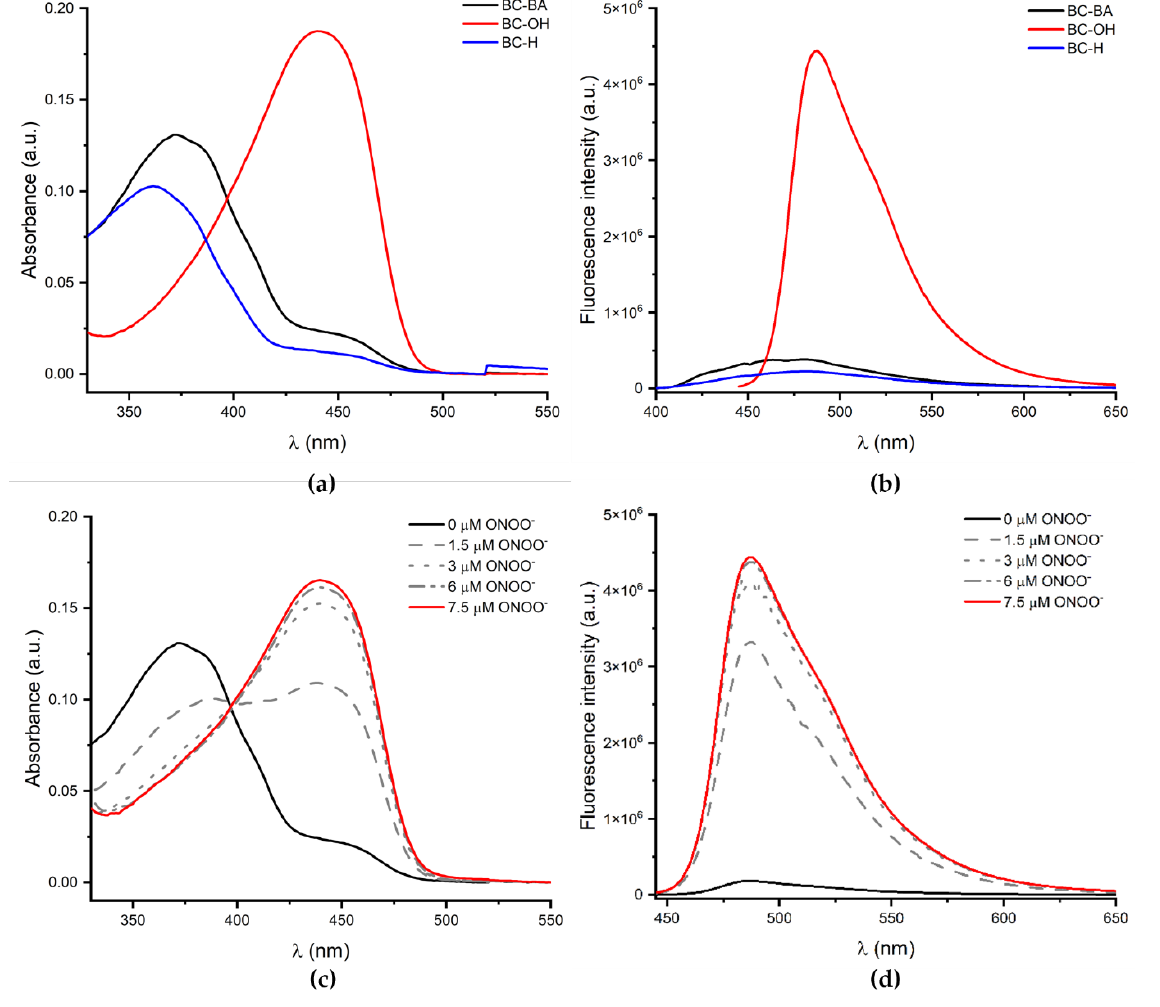
Figure 1. Absorption and emission spectra of studied coumarins recorded in mixture of phosphate buffer (0.1 M, pH 7.4) and EtOH (10%). ( a ) Absorption spectra of BC-OH , BC-BA, and BC-H (5 µM each); ( b ) fluorescence spectra of BC-OH , BC-BA, and BC-H (5 µM each , λ ex = λ max ); ( c ) absorption spectra of BC-BA probe (5 µM) recorded before and after bolus addition of different amount of peroxynitrite (0, 1.5, 4.5, 6, 7.5 µM); ( d ) emission spectra of the BC-BA probe (5 µM , λ ex = 442 nm) recorded before and after bolus addition of different amount of peroxynitrite (0, 1.5, 4.5, 6, 7.5 µM).